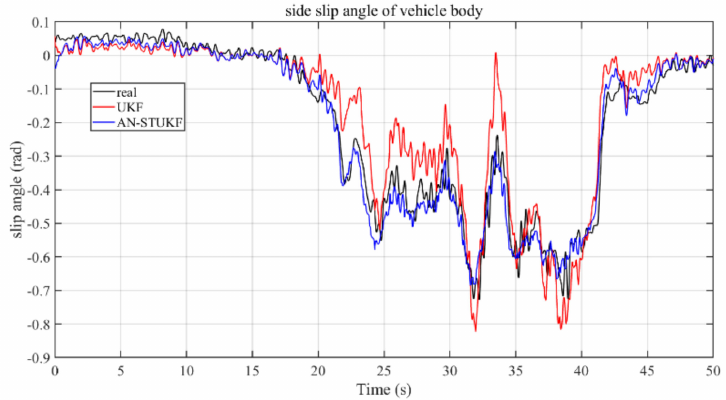
Figure 12. The sideslip angles of the vehicle body.